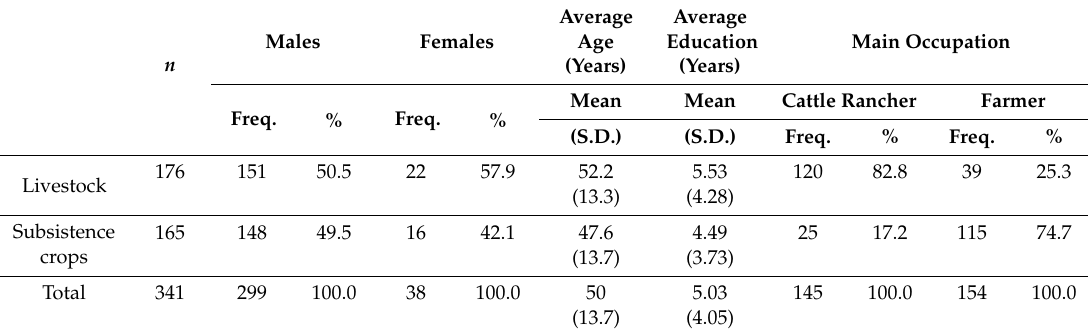
Table 1. Characteristics of the household head.